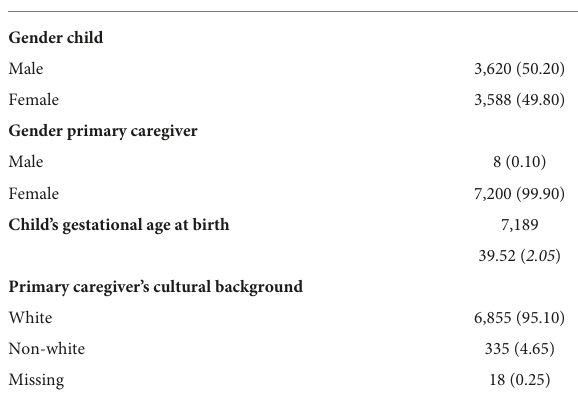
TABLE 1 Demographics and background information of the primary caregiver and the